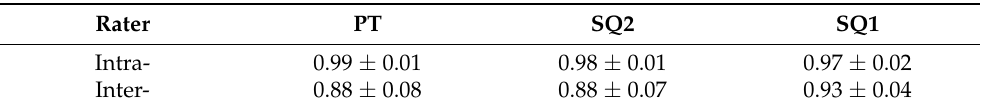
Table 4. Mean and SD of Krippendorff’s alpha ( α k ) when studying intra- and inter-rater reliability of individual ISMs (PT-60 pixels, SQ2-two small squares, SQ1-one big square). Rater PT